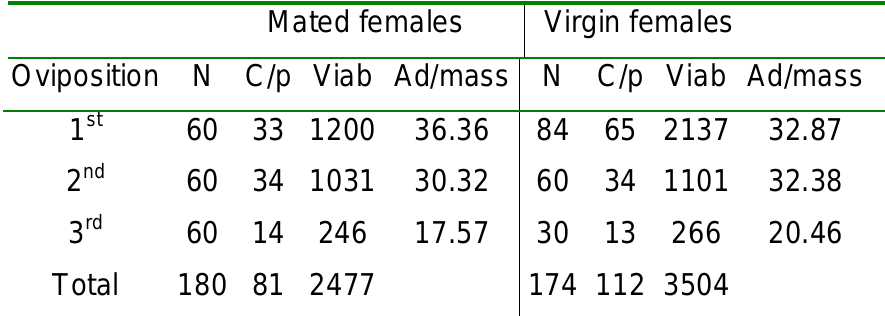
Table 1: Diatraea saccharalis caterpillars parasitized by mated and virgin females of Cotesia flavipes in the 1 st , 2 nd and 3 rd ovipositions.